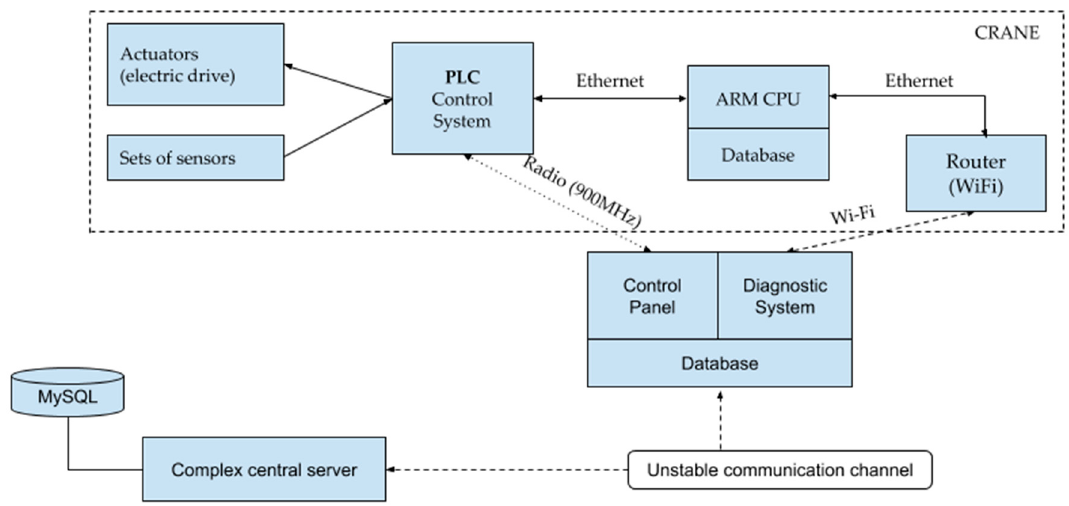
Figure 10. Developed and implemented structure of the DC system at crane complexes.